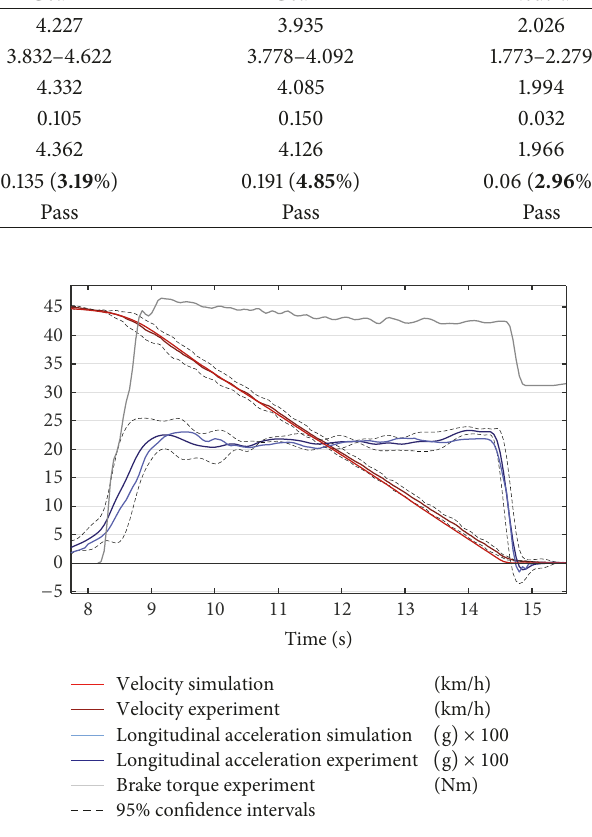
Figure 16: Validation Maneuver Long-II: experimental data